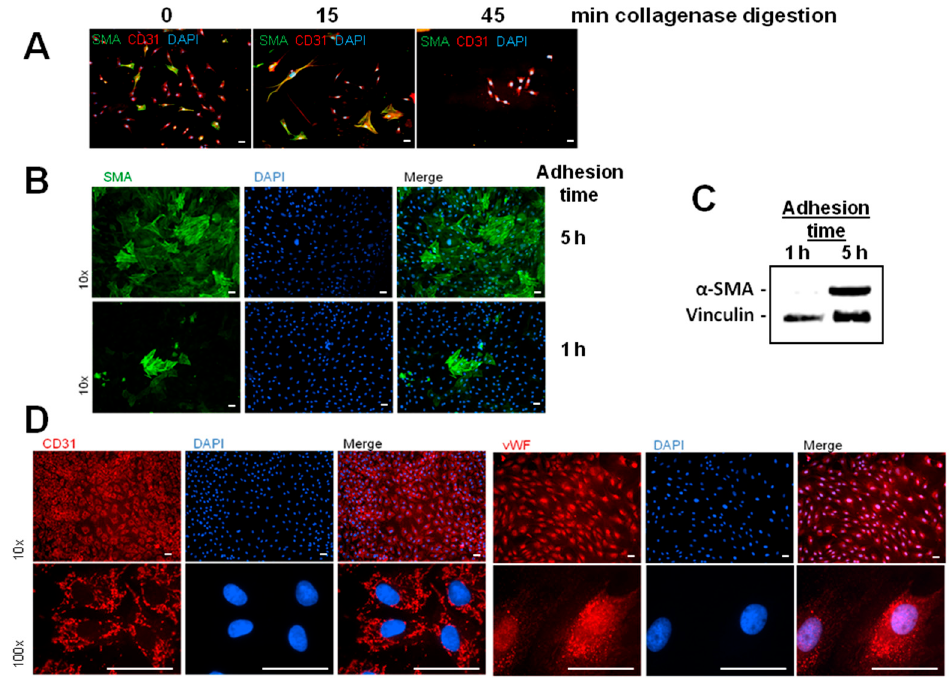
Figure 1. Establishment of pure endothelial cell cultures. ( A ) Endothelial cells were isolated as described in the method section. After separation of cardiomyocytes from other cardiac cells, the remaining cells were redigested with collagenase (400 mg/L) for 0, 15, or 45 min. Then cells were plated on culture dishes and immnuofluorescene was performed using antibodies against α -SMA (green) and CD31 (red), as well as DAPI was used for nuclear staining (blue); ( B – D ) cells with a redigestion time of 45 min were plated on culture dishes. After one or five hours adhesion time, cells were rigorously washed, cultured to 95% confluence and once passaged. Either immunofluorescence or Western blots were performed when the cell layer reached around 95% confluence; ( B ) immnuofluorescene was performed using antibodies against α -SMA (green). Nuclei were staind with DAPI (blue); ( C ) Western blot of total protein using α -SMA antibodies and vinculin antibodies for loading control; ( D ) immnuofluorescene was performed using antibodies against CD31 (red) or von Willebrandt factor (vWF, red) to detect endothelial cells. Nuclei were stained with DAPI (blue). Scale bars: 50 µm